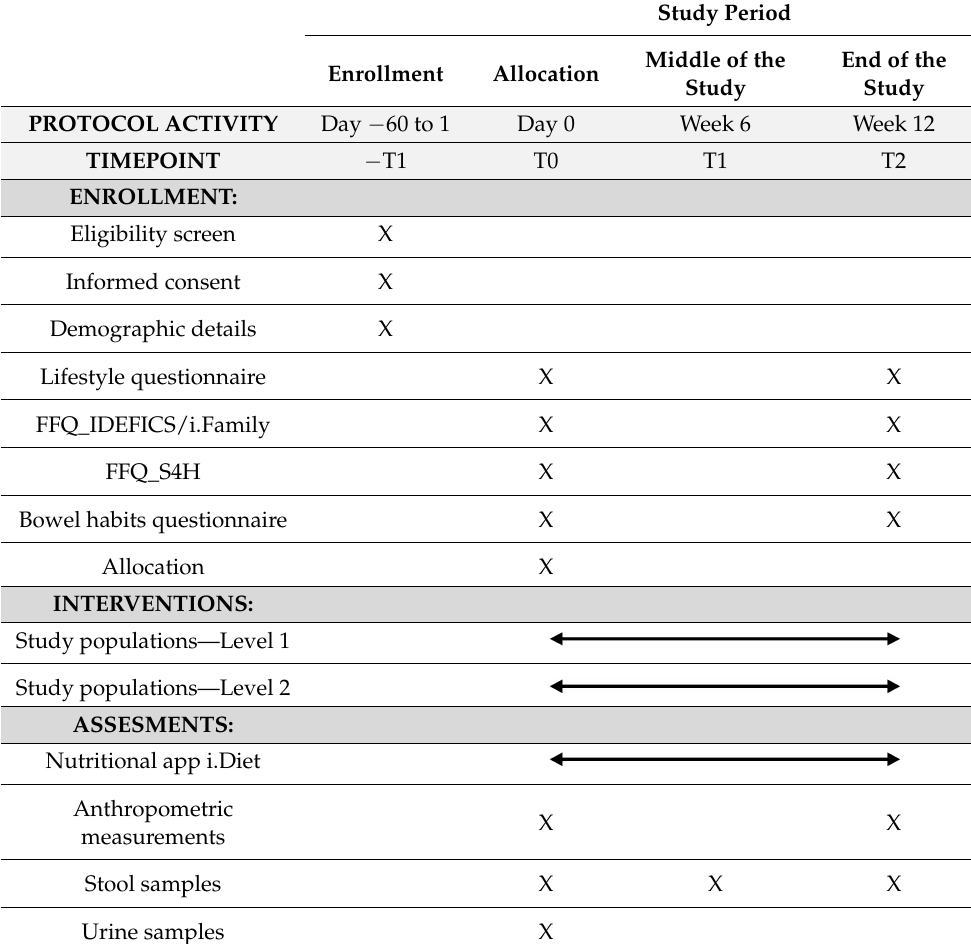
Table 1. Schedule of enrollment, interventions, and assessments for